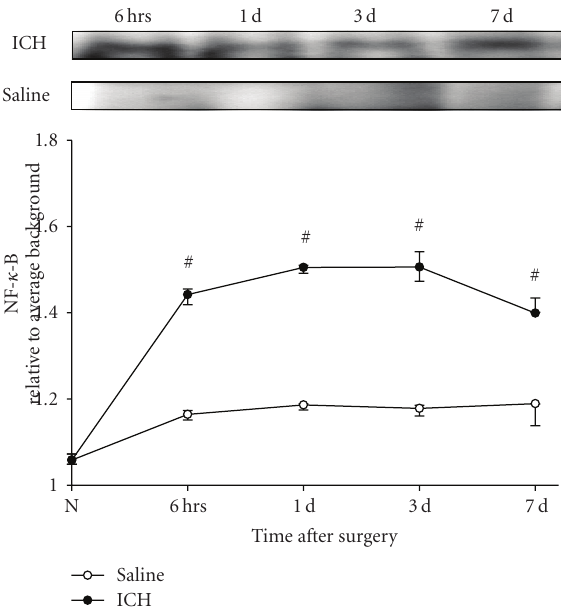
Figure 4: NF κ B activation in the brain in the rats subjected to ICH . Nuclear proteins were isolated from brain tissues and the NF κ B binding activity was examined by the method of EMSA. The signals were quantified by scanning densitometry and computer- assisted image analysis. The results were expressed as the ratio of the integrated density volume (IDV) of NF κ B to the average IDV of background. The results showed that the activity of NF κ B increased at 6 hours after ICH ( P < . 05), peaked on 3 days after ICH and maintained a high level on 7 days after ICH ( P < . 05). #: compared with saline control, P < . 05).